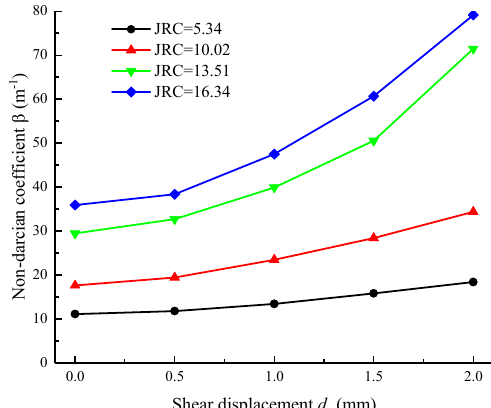
Figure 12. Relationship between the non-Darcian coefficient and shear displacement.